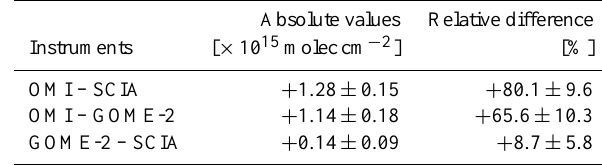
elastic scattering (the + C Ring I Ring (λ)/I 0 (λ) term) to the re- flectance spectrum.